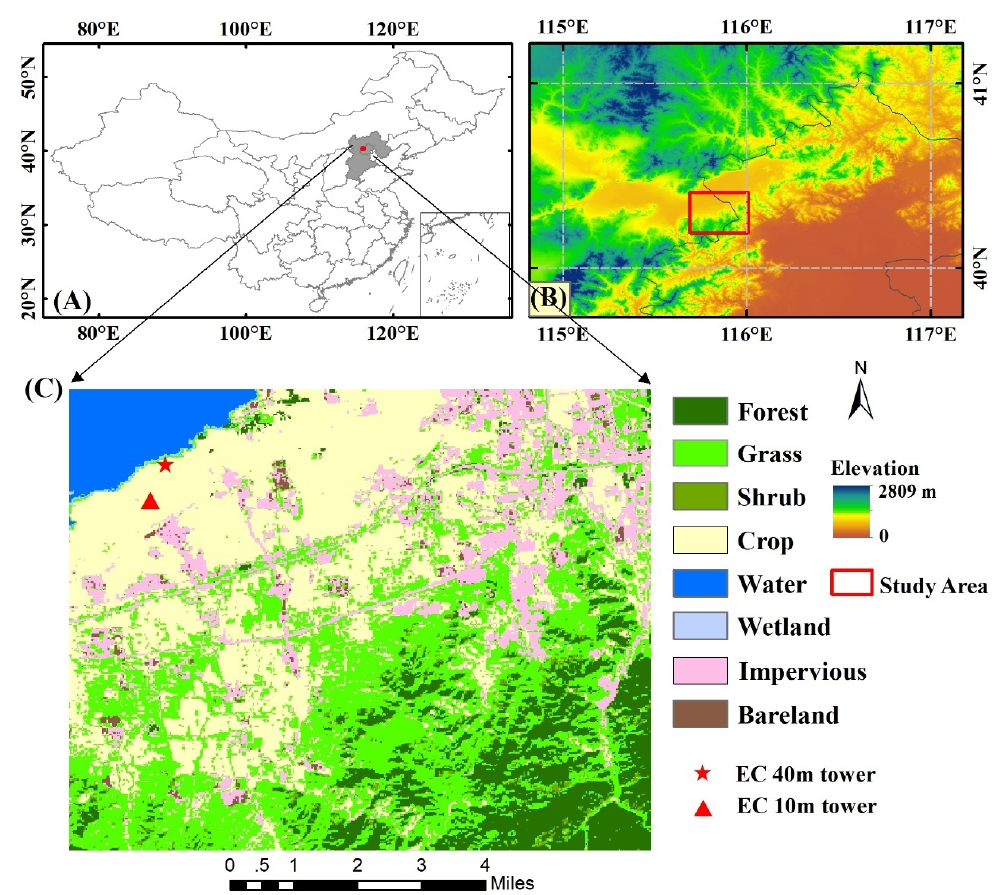
Figure 1. Maps showing ( A ) the location of the study area ( B ) the digital elevation model (DEM) data of the study site ( C ) the distribution of land cover type and the location of EC towers.